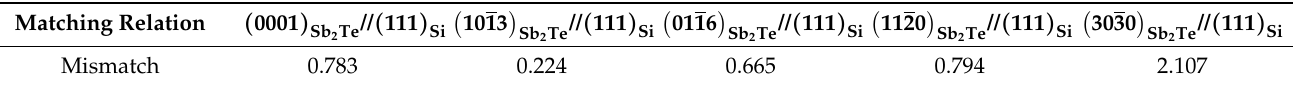
Table 6. Mismatch between the various crystal planes ((0001), Sb 2 Te thin film and the (111) crystal plane of Si